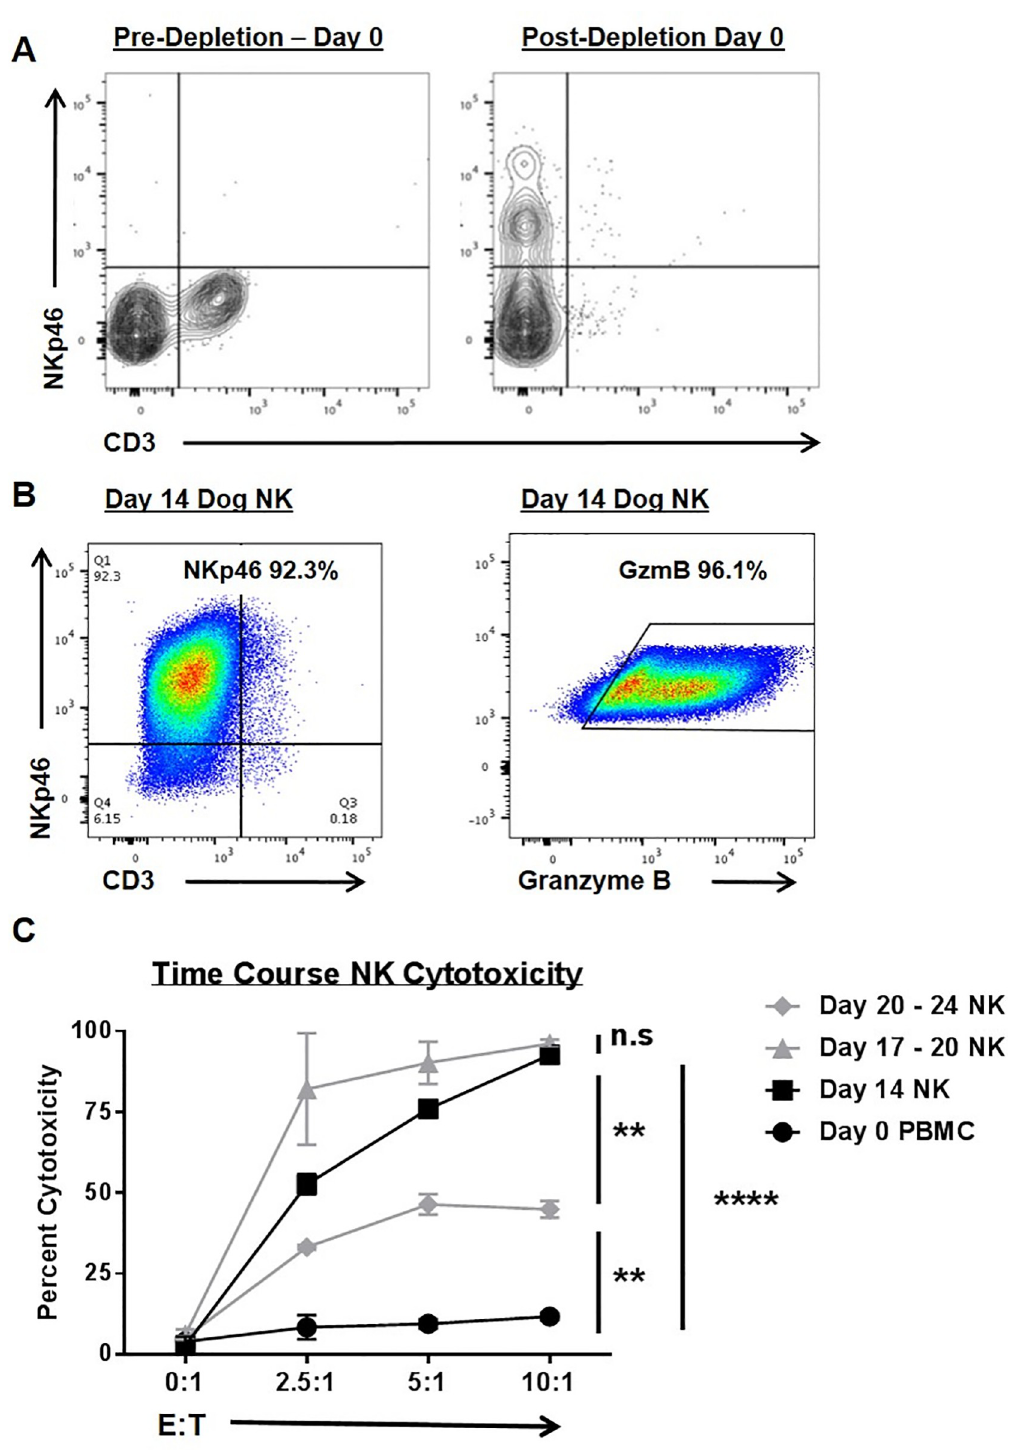
Fig 2. Canine NK cells are enriched in NKp46 and Granzyme B expression with time-dependent changes in cytotoxic function. (A) Canine NK cells were isolated from peripheral blood mononuclear cells via CD5 antibody depletion (left), thereby enriching for a CD3-NKp46+ population of cells (right). (B) Ex vivo expansion with an irradiated feeder cell line (human K562 leukemia line transduced with 4-1BBL and membrane bound IL-21) yields a CD3 population of cells that are markedly positive for NKp46+ (left) and Granzyme B+ (right) after 14 days of stimulation. For panels A and B, representative